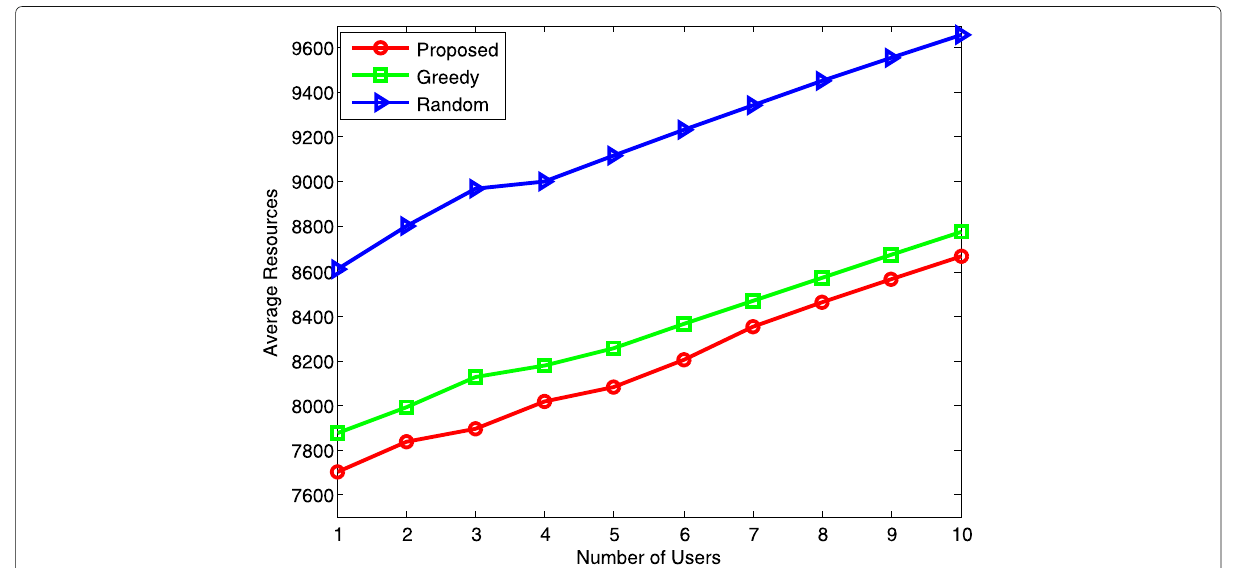
Fig. 8 Average resource results for proposed framework versus greedy and random